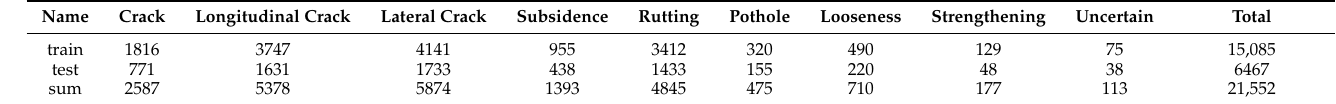
Table 1. Mathematical statistics of different types of damage in training set and test